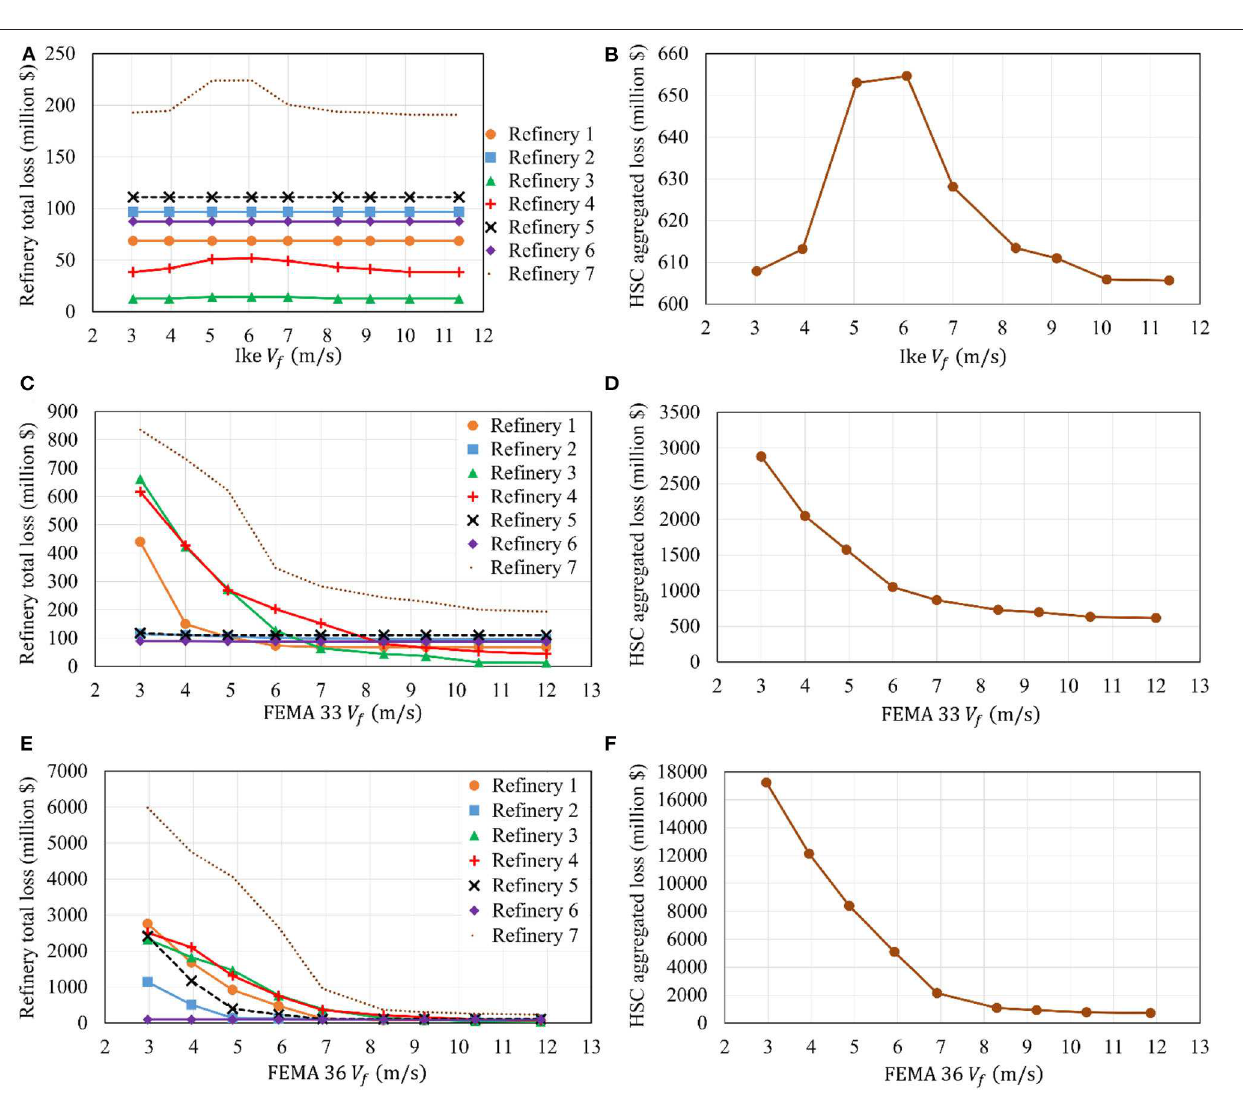
FIGURE 11 | Effect of forward speed of Hurricane Ike, FEMA 33, and FEMA 36 on the refinery total losses and the HSC aggregated loss (SLR = 0cm).